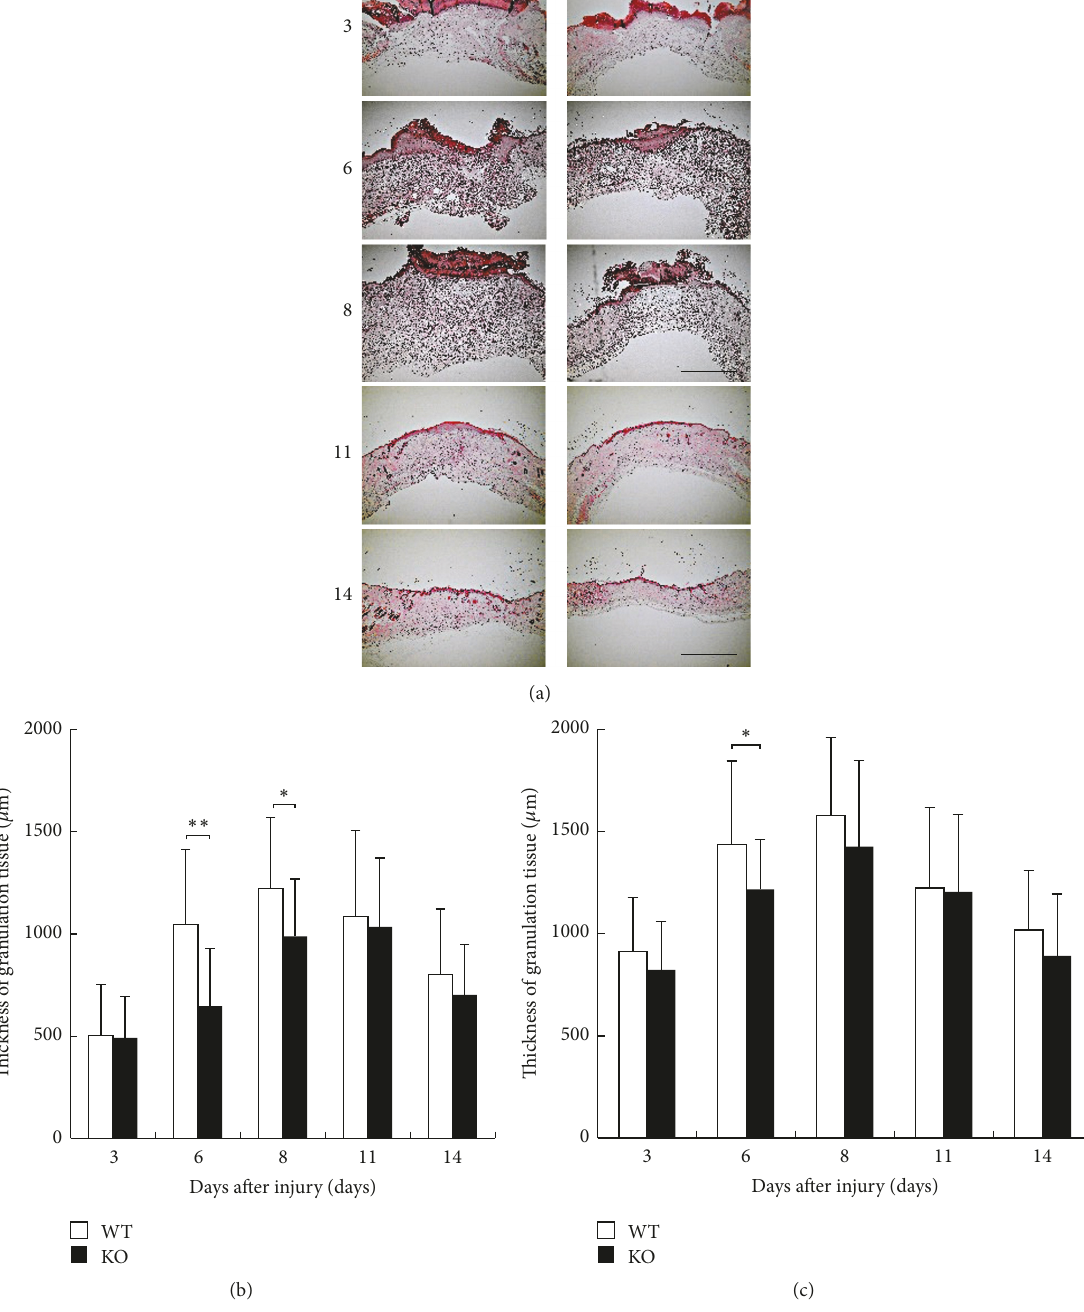
Figure 2: (a) Histology of healing wound tissue by hematoxylin and eosin stain at the indicated time intervals in dorsal skin of inducible nitric oxide synthase (iNOS-) knockout (KO) mice and WT mice. (b) The thickness of the granulation tissue at the center zone was thinner in KO mice than in WT mice at days 6 and 8 with a statistically significant difference. (c) At the margin zone, the thickness of the granulation tissue was significantly thinner in KO mice than in WT mice at day 6. Open bars: WT, filled bars: KO (days 3, 11, and 14: 𝑛 = 6 ; days 6, 8: 𝑛 = 7 animals in each group). Mean ± standard deviation. ∗ 𝑝 < 0.05 ; ∗∗ 𝑝 < 0.01 ; bar,